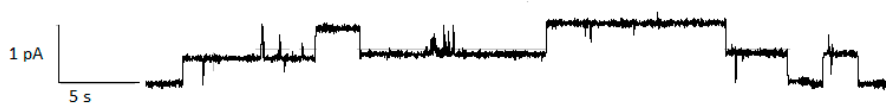
Figure 2. Planar bilayer voltage clamp trace for 2 in asolection bilayers, applied voltage = 30 mV, 10 mM HEPES buffer, [KCl] = 450 mM.